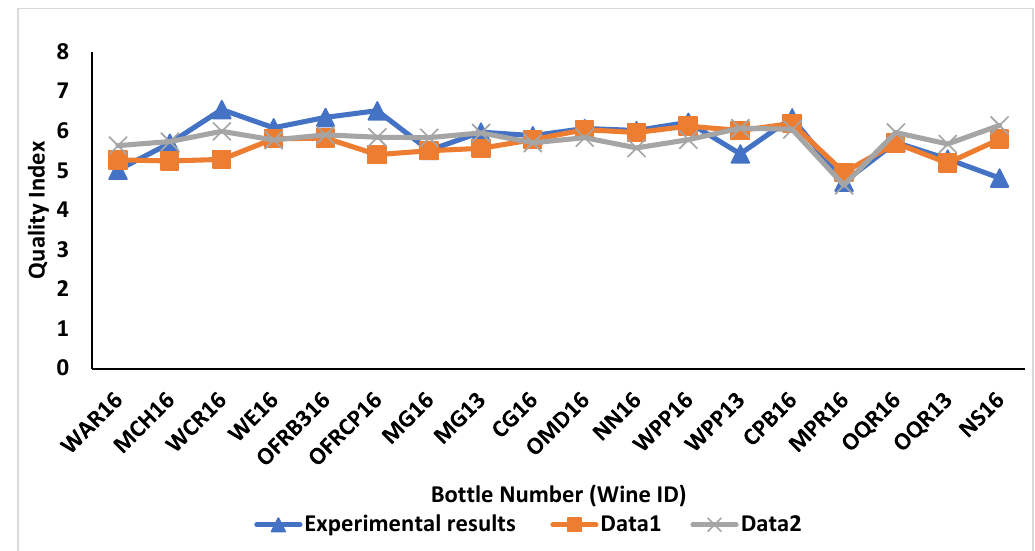
Figure 9. Wine quality prediction for data1 and data2 based on MAE as evaluation metrics using deep neural networks.